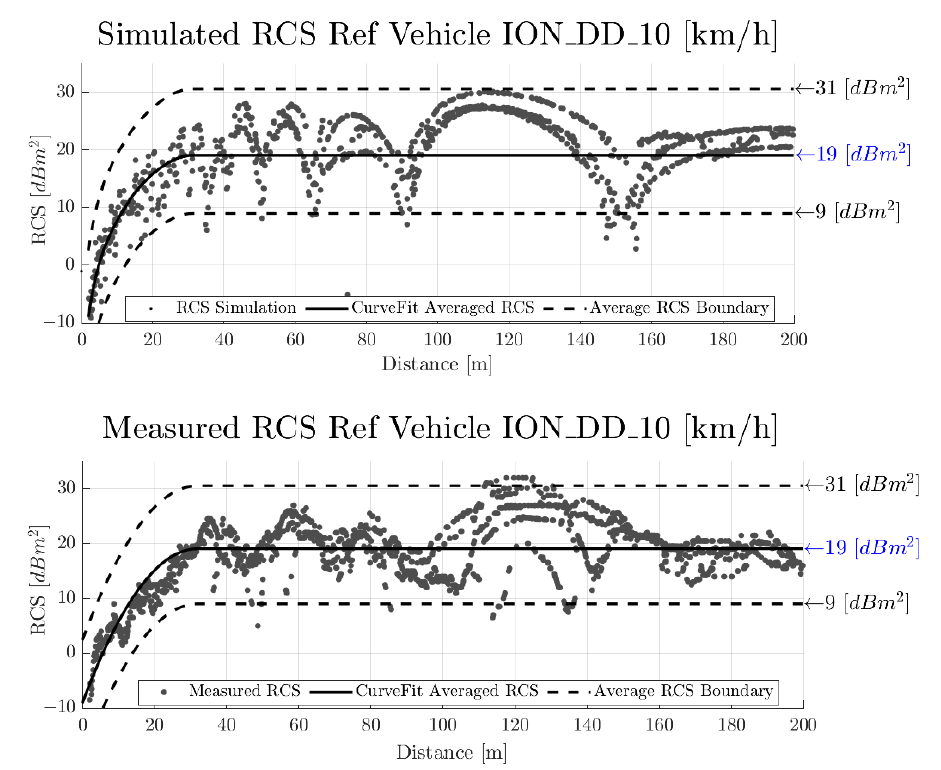
Figure 10. Evaluation of the synthetically generated ( top ) and the measured real radar point cloud ( bottom ) in terms of the radar cross-section signal (RCS), following the procedure described in